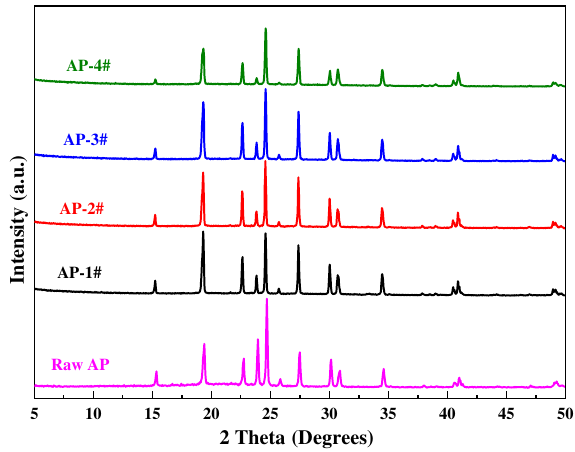
Figure 5. XRD patterns of raw AP and laminated AP composite samples.